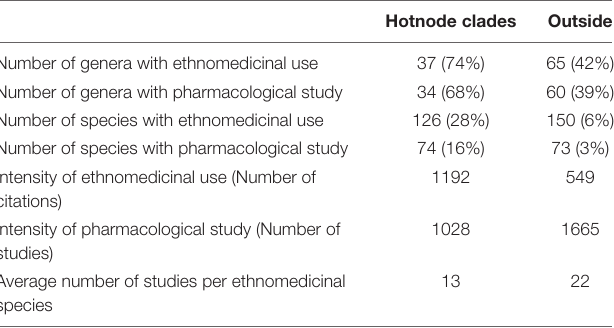
TABLE 1 | Characterization of “hotnode clades” in terms of absolute numbers and proportions of species and